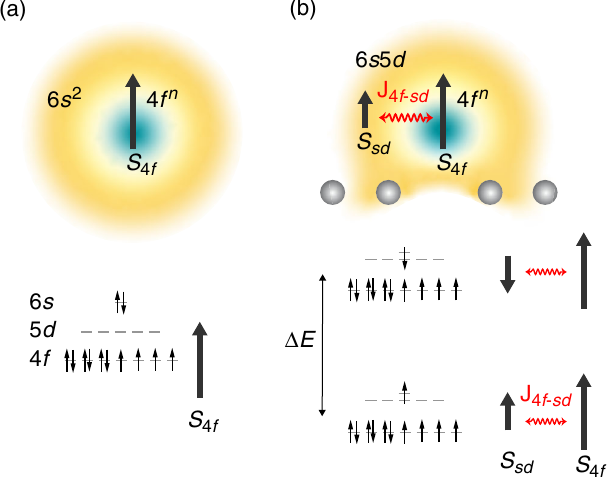
FIG. 2. Intra-atomic exchange in RE atoms. (a) Top diagram: Sketch of the radial distribution of the 4 f and 6 s atomic orbitals for a gas phase RE atom ( 6 s 2 5 d 0 4 f n ). Bottom diagram: Corre- sponding atomic shell filling (case of Dy, n ¼ 10 ). (b) Top diagram: Adsorption on graphene, promoting the transfer of approximately one electron to graphene, resulting in partially filled, spin-polarized outer shells [ ð 6 s 5 d Þ 1 4 f n ]. Note that J 4 is the intra-atomic exchange constant. Bottom diagram: Ex- change-split energy levels for the case of an outer shell with ¼ 1 = 2 . The ferromagnetic and antiferromagnetic con- spin S sd figurations are separated by Δ E